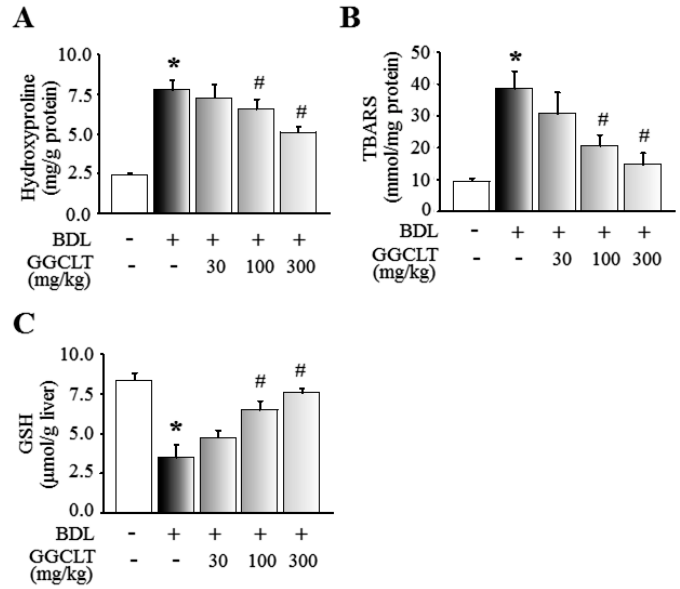
Figure 3. GGCLT reduced BDL-induced oxidative stress in the liver tissues of mice. ( A ) Hepatic hydroxyproline content; ( B ) hepatic lipid peroxidation represented by thiobarbituric acid reactive substances (TBARS); and ( C ) hepatic glutathione (GSH) levels. * p < 0.05 vs. sham-control mice ( n = 6); # p < 0.05 vs. BDL mice ( n = 8).